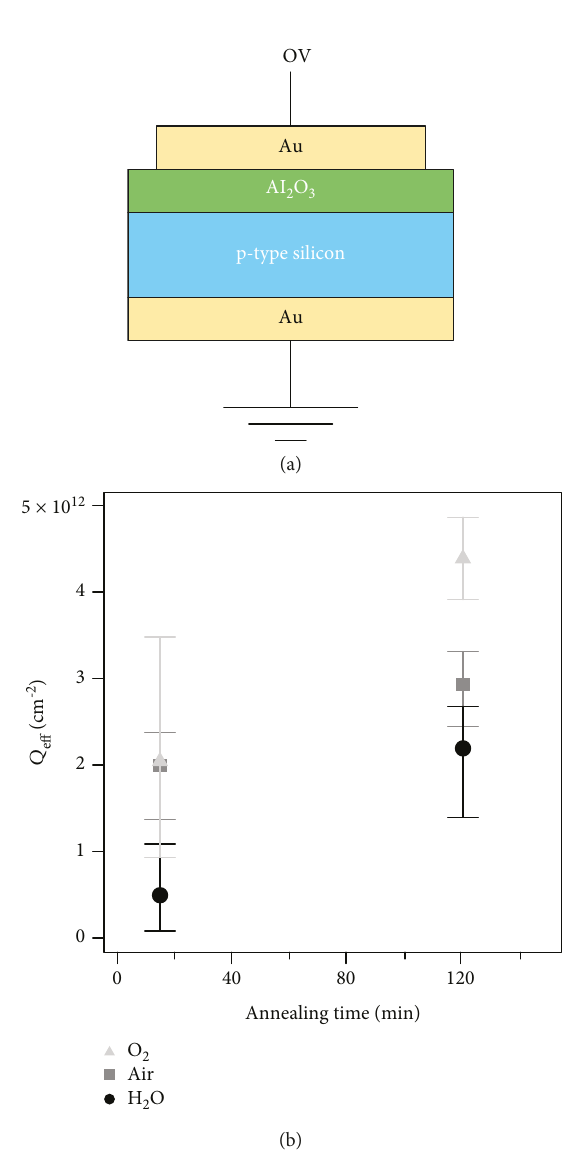
Figure 5: (a) Schematic of the device prepared for C-V measurement. (b) E ff ective charge density of the annealed sample in ambient H O/O , O , and air for 15 or 2 2 2